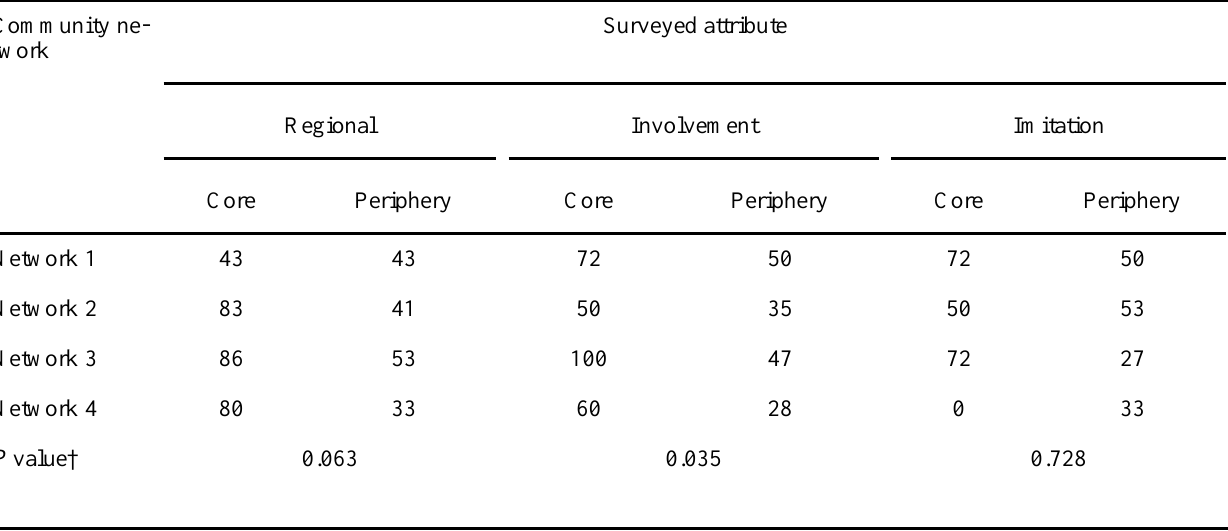
Table 3. Percentages of core and periphery members who identified themselves as settler farmers (regional), who reported involvement in community activities (involvement), and who reported imitation of other farmers’ practices (imitation) for the four community networks.